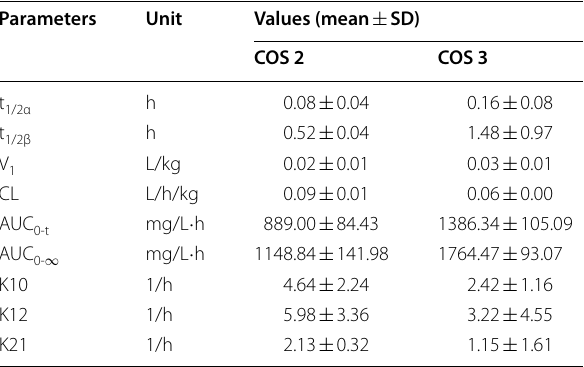
SD, n 5, data from ± =